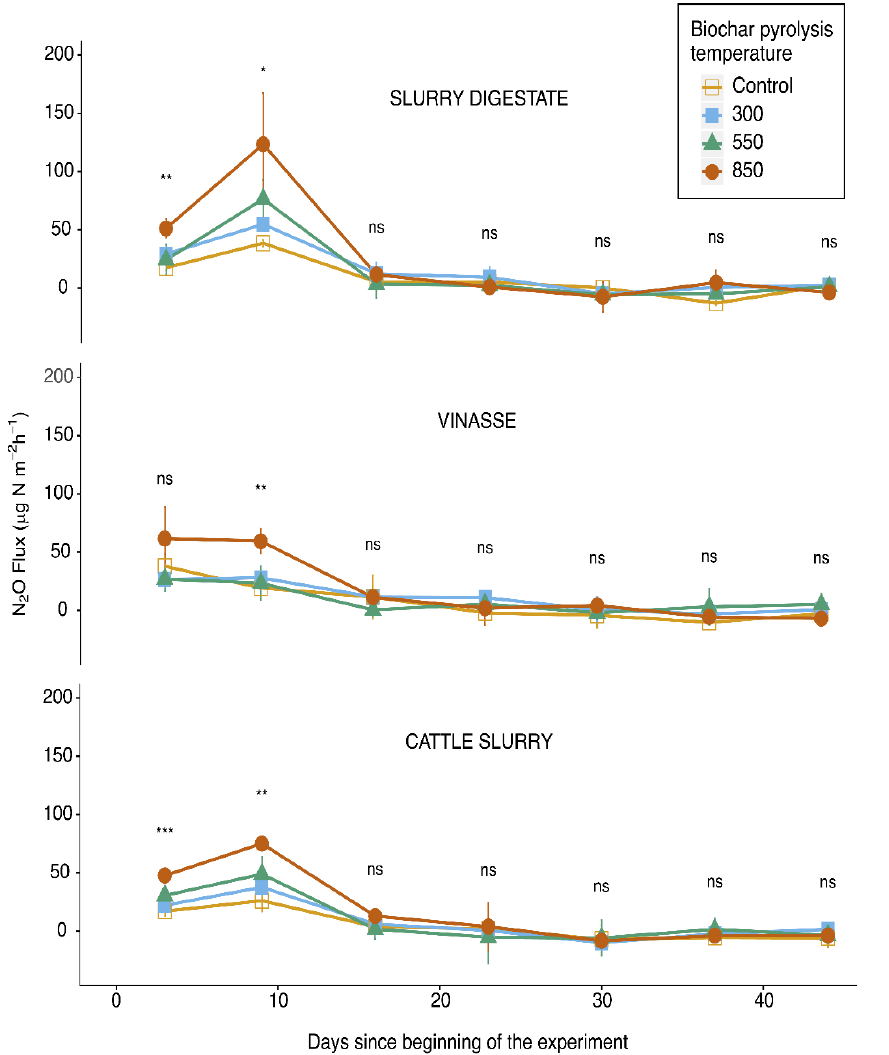
Figure 4. N 2 O-N fluxes for each fertilizer and production temperature biochar during the studied period (BC300: Biochar produced at 300 °C; BC550: Biochar produced at 550 °C; BC850: Biochar produced at 850 °C). Stars indicate significant differences according ANOVA (*: p < 0.05; **: p < 0.01; ***: p < 0.001; ns: not significant). Table 5. Final pH KCl for the different treatment level combinations.